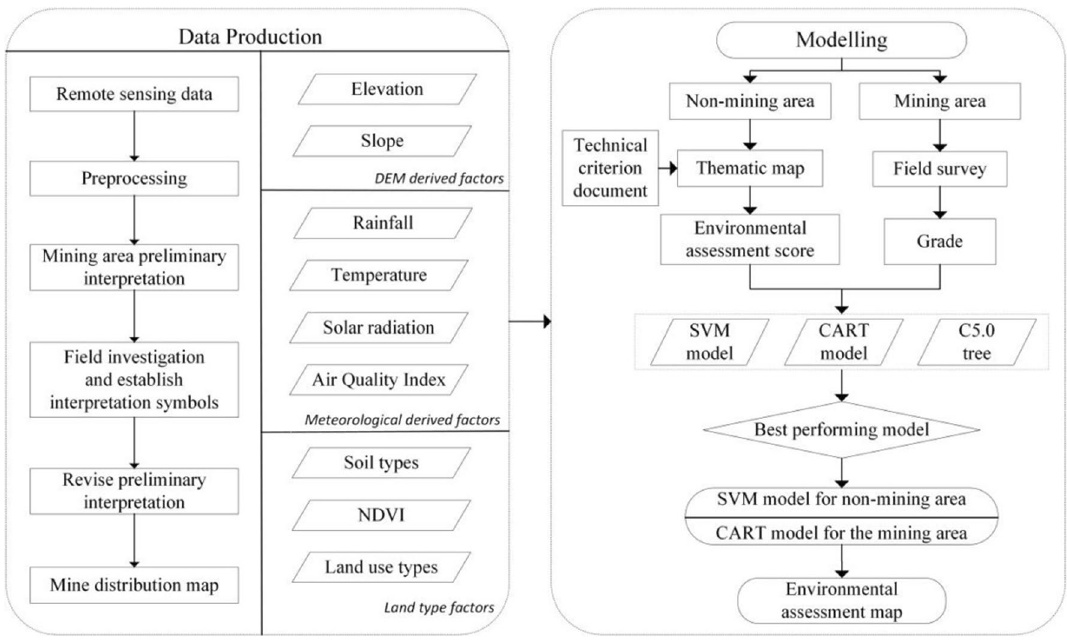
Figure 4. Methodological flowchart of the research